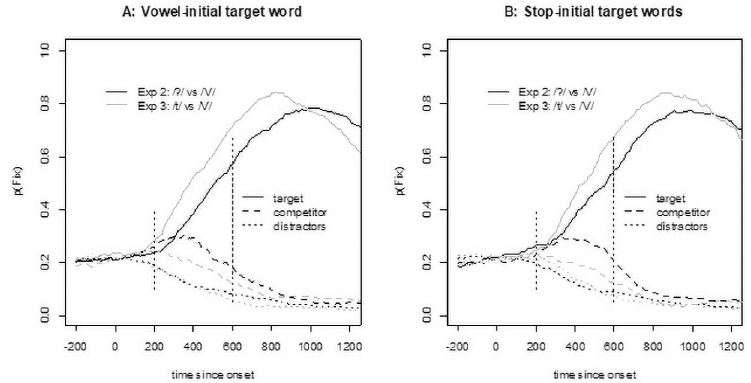
Fig 9. Eye-movement data from Experiment 3 (/t/-initial words) compared with Experiment 2 (/ ʔ /-initial words).